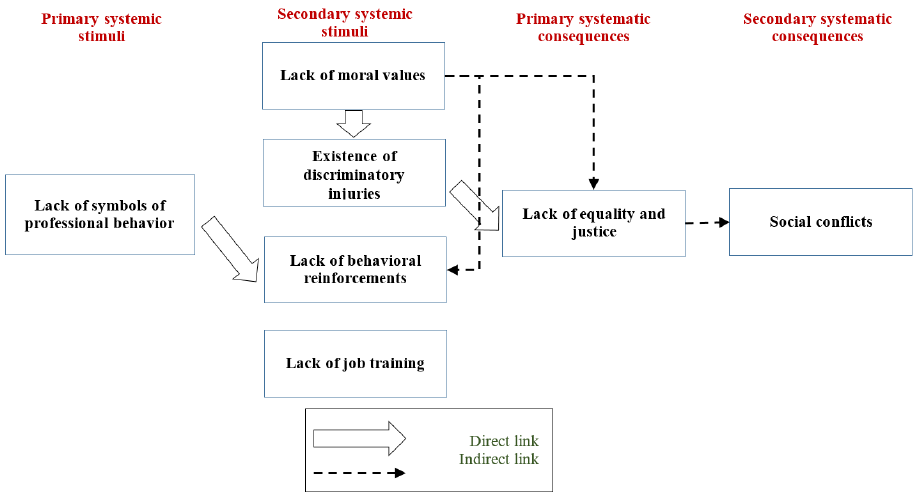
Figure 2. Systematic representation model of the impact of research